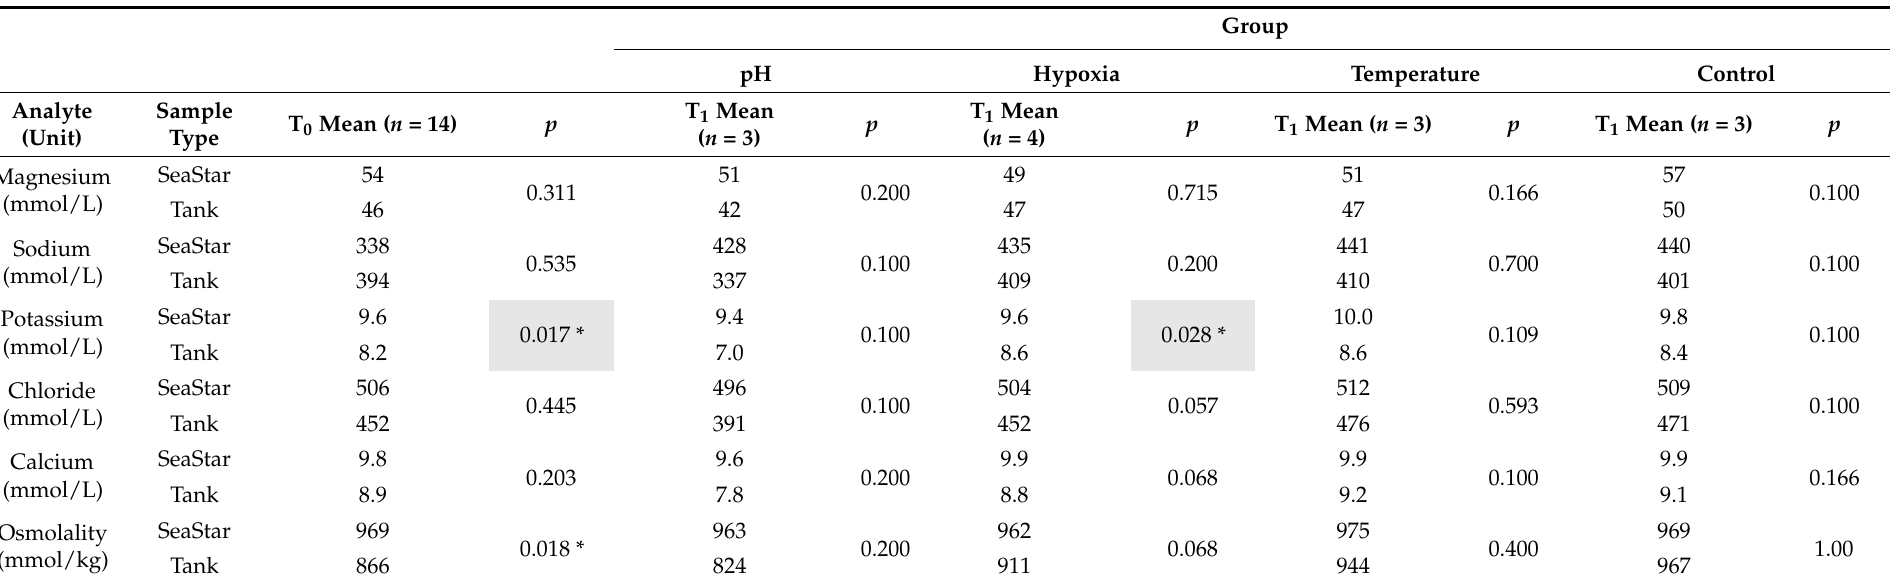
Table 6. Common sea star ( Asterias rubens ) coelomic fluid [SeaStar] compared to tank water [Tank] electrolyte and osmolality using a Wilcoxon rank sum test. Coelomic fluid and tank water samples were paired for analysis; the sample size ( n ) given represents the number of individuals for each type of analysis. Statistical significance was determined with p < 0.05. Sea stars were randomly assigned to one of four groups: decreased pH ( − 0.4 units), hypoxia (target dissolved